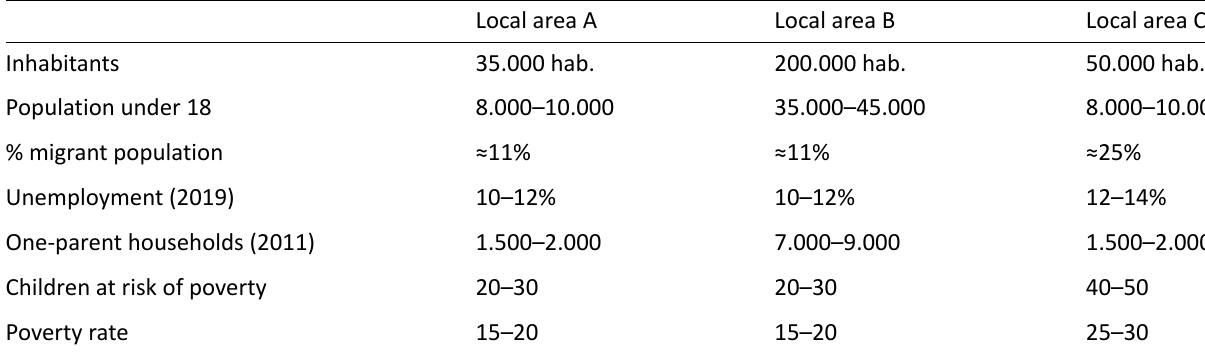
Table 1. Key characteristics of the local